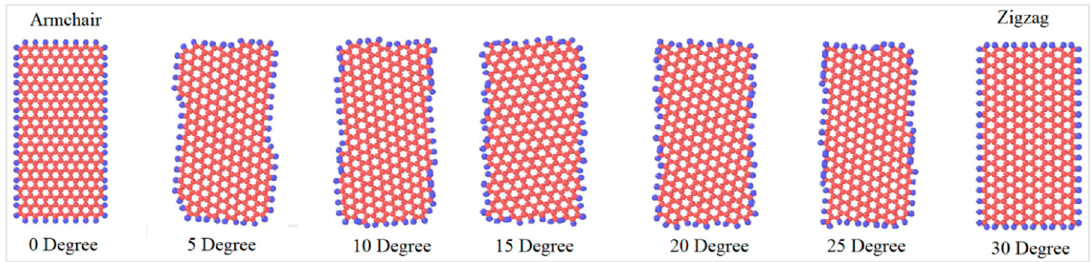
Figure 2. Simulated graphene nanoflakes with different chiral angles with respect to the substrate.